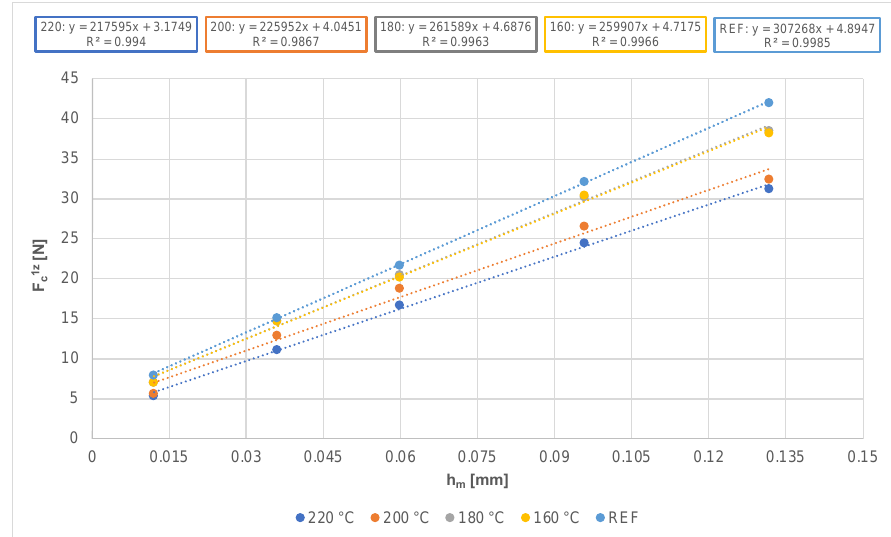
Figure 5. Dependance of average values of cutting force per single tooth on uncut chip thickness.